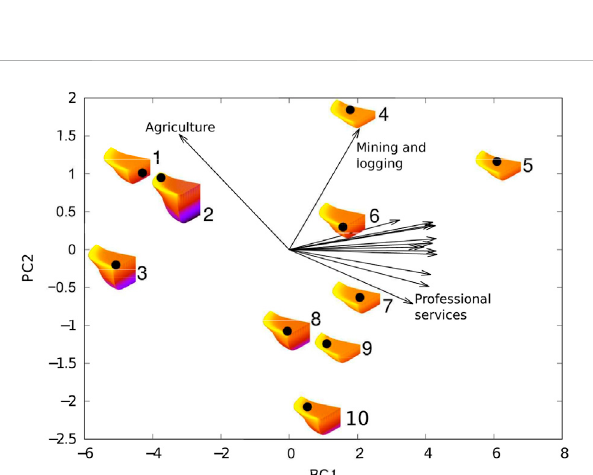
FIGURE 5 PrincipalcomponentsanalysisordinationofSESsbyemployment levels per sector, February, 2020. Each SES is represented by a visualization of its economic cascade under the business-as-usual model, equivalent to examples illustrated in Figures 3C, D. Eigenvectorelementsrepresentthecontribution ofeachsectortothe ordination and are projected onto the principal component space (arrows), thus explaining sector contributions to relative SES ordination. PC 1 is thus shown to be a contrast between the Agriculture sector and all others, while PC 2 is a gradient of increasing goods producing versus services providing sectors. Arrow length is proportional to the in fl uence of the sector on the ordination.